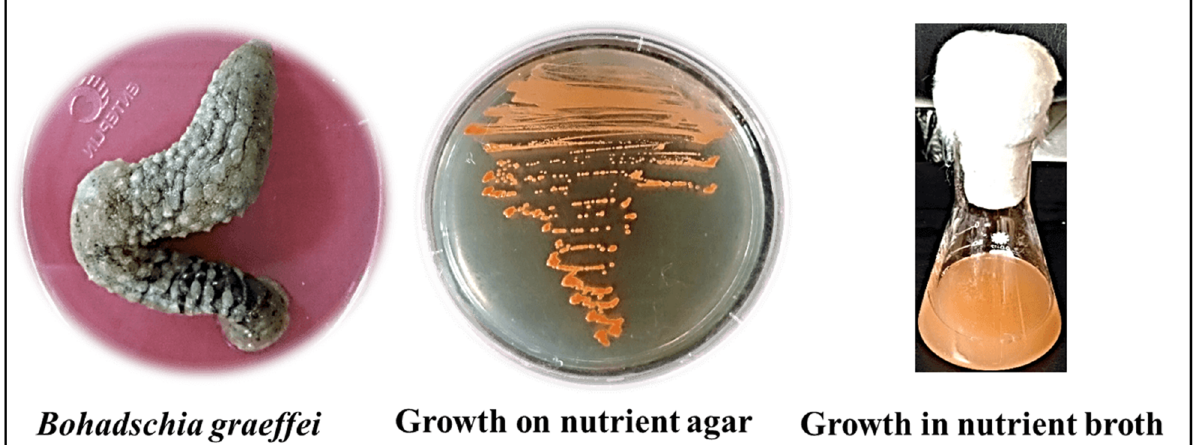
Figure 1. Kocuria sp. RAM1 with orange pigmentation isolated from Bohadschia graeffei, Marsa Alam, Red Sea, Egypt.